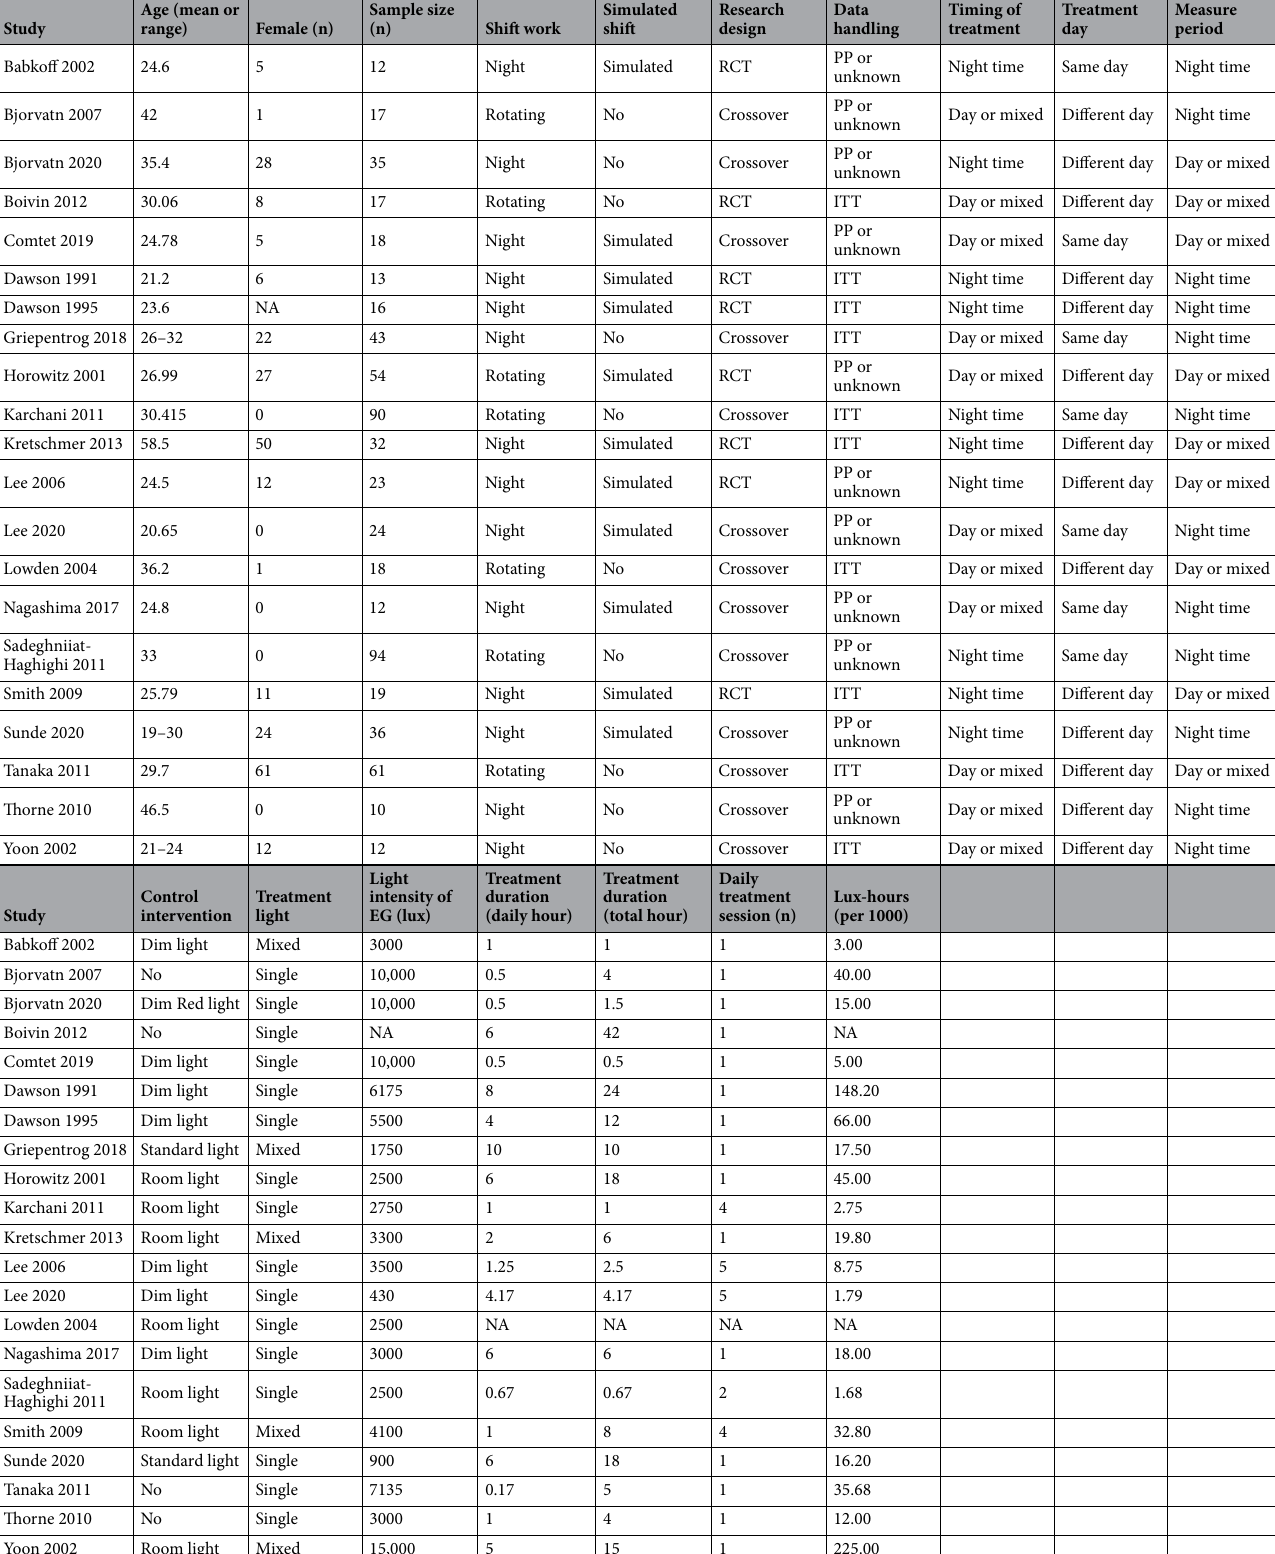
Table 4. Moderators used in subgroup and metaregression analyses. RCT randomized controlled trial, Crossover randomized crossover trial, ITT intention-to-treat, PP per